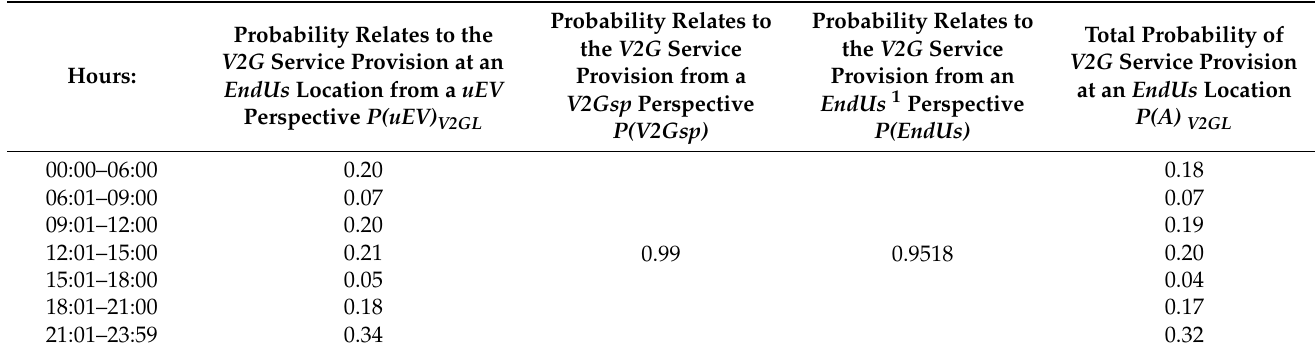
Table 5. Calculation of probability values P(A) .